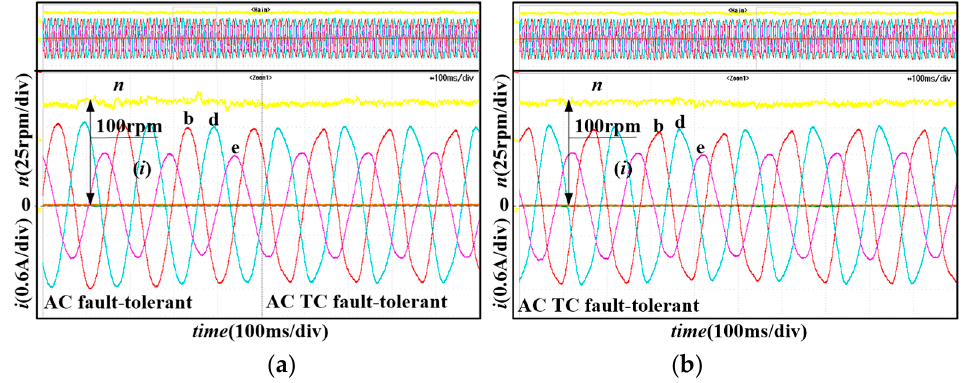
Figure 15. The experimental results of AC TC fault-tolerance: ( a ) AC fault-tolerance to AC TC fault-tolerance;( b ) AC TC fault-tolerance.